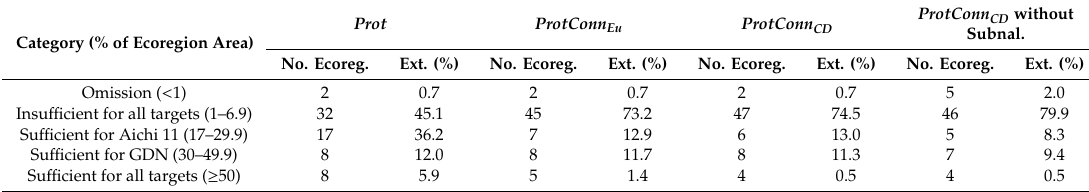
Table 2. Number of ecoregions and TAC extension that meet the 17%, 30%, or 50% global targets: connectivity evaluations (d med = 10 km) and subnational